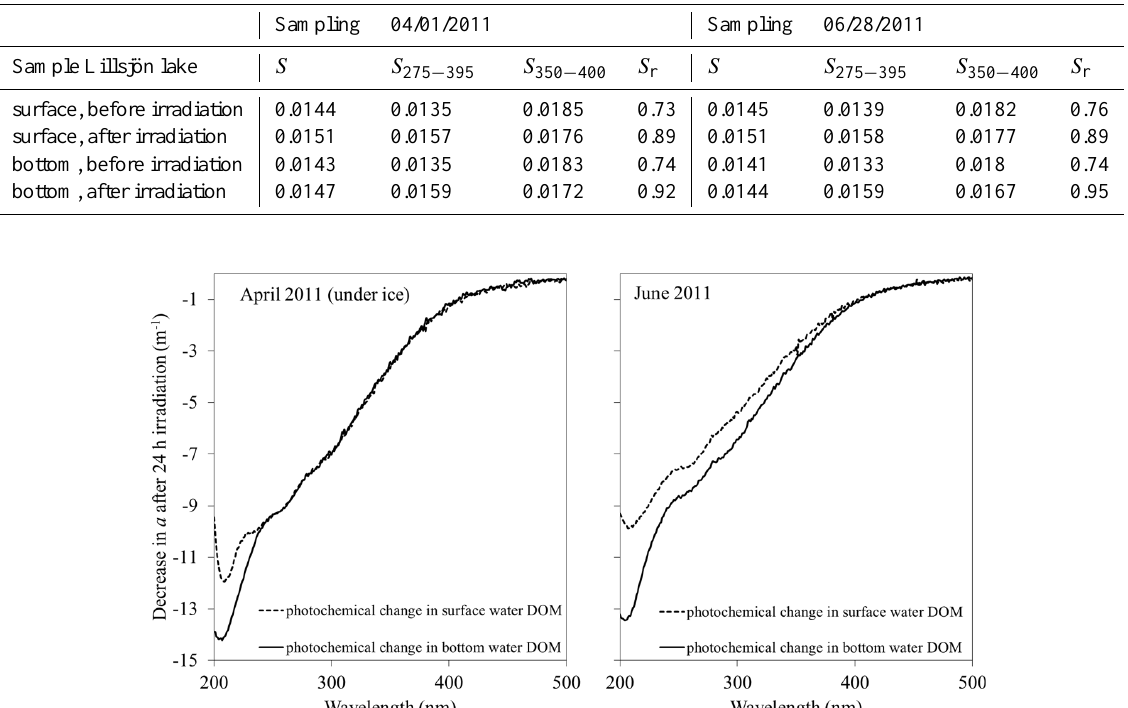
Fig. 3. Depth-dependent seasonal changes in the photochemical degradation patterns after 24h exposure to simulated sunlight of lake SPE- DOM and analyzed by UV/Vis absorption